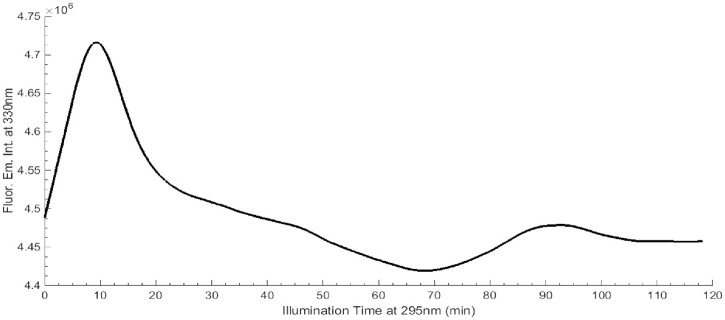
Continuous 295 nm excitation of LYZ at 20°C, for 2 hours.Fluorescence emission at 330 nm and excitation slit was set at 0.1 mm (0.1 μW).